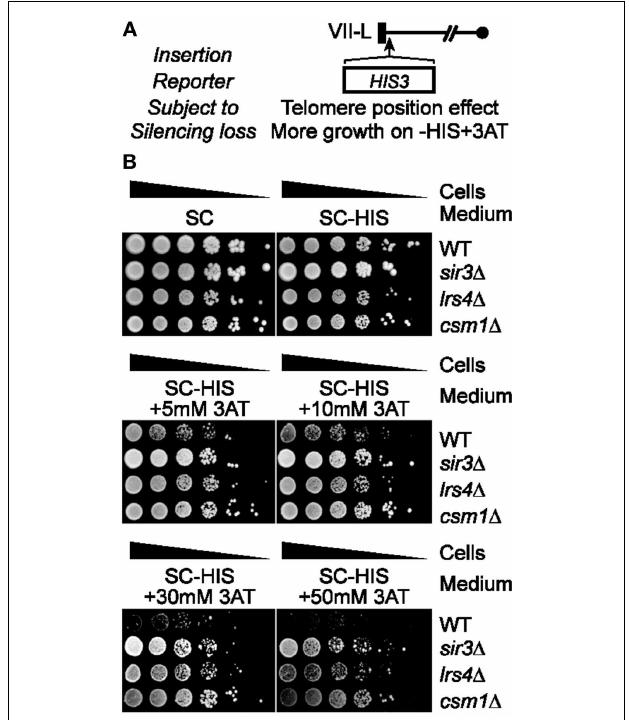
FIGURE 1 | Cohibin is required for silencing of the telomeric reporter gene HIS3 . (A) Schematic of the HIS3 reporter gene inserted proximal to TELVII-L. (B) Serial dilutions of cells with the telomeric HIS3 reporter were plated on synthetic complete (SC) medium or SC media without histidine ( − HIS) and with increasing concentrations of 3-amino-1,2,4-triazole ( + 3AT; HIS3 silencing inhibits growth).WT, wild-type. Strains: KMY984, KMY986, KMY1303,